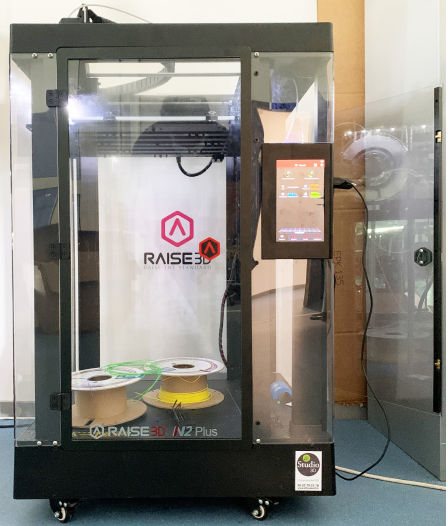
Figure 21. Rise 3D Printer V2 Plus used to manufacture the printed parts in Figures 15, 18 and